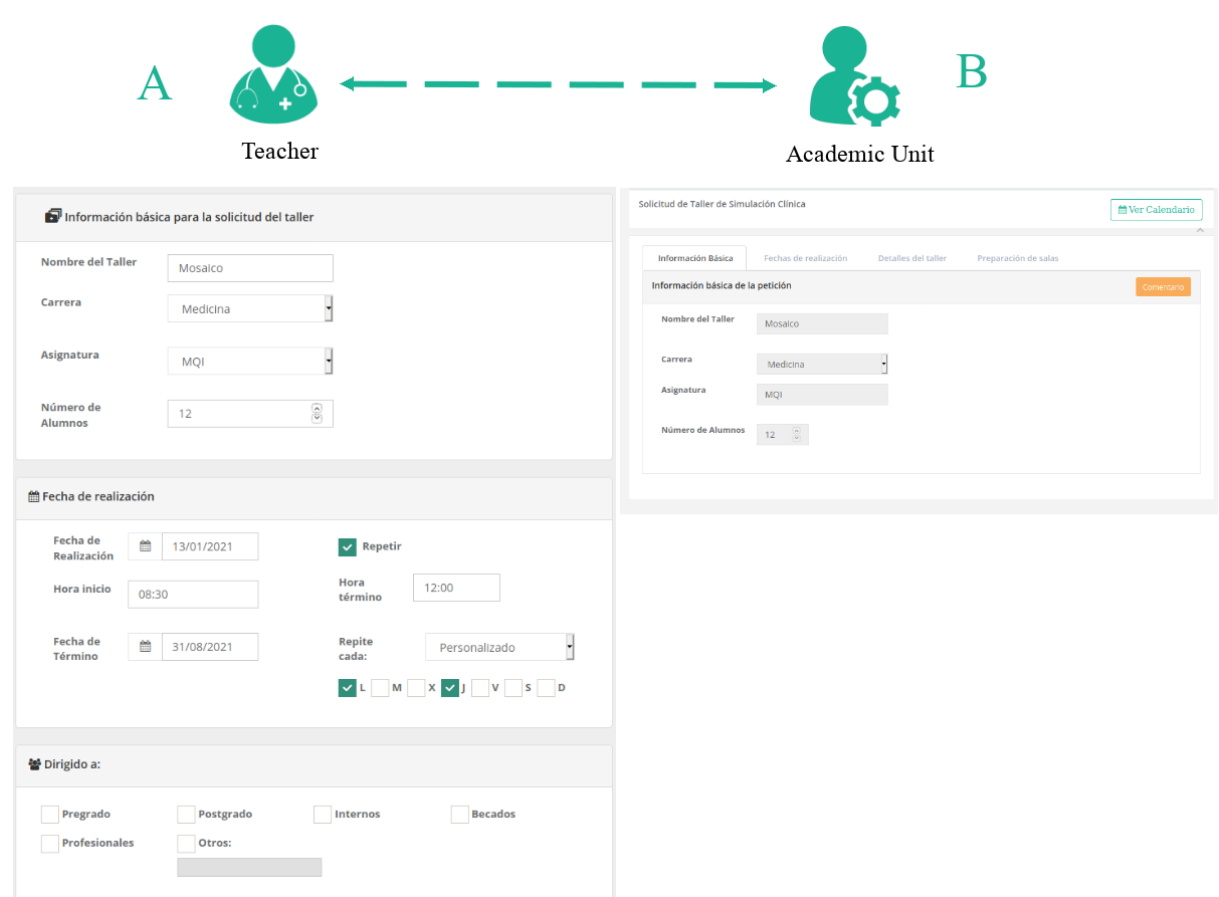
Figure 4. Educational design module. Form to request a clinical simulation to the academic simulation unit director (A), who reviews the request and sends comments to the teacher